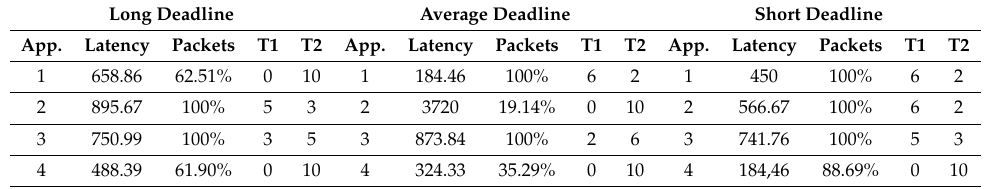
Table 5. Irregular topologies with 15 cores.